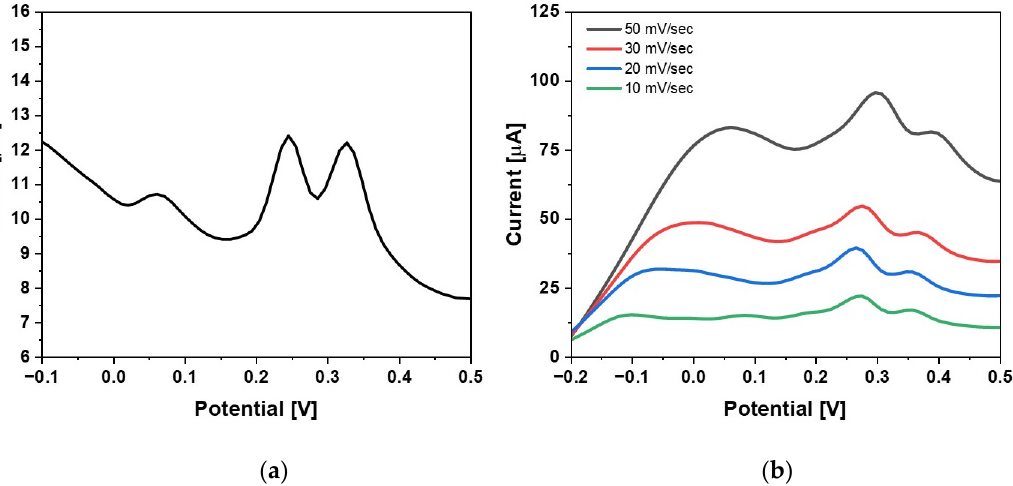
Figure 3. Oxidation peak determination. ( a ) Oxidation peaks of AA, DA and UA in whole blood using LSV; and ( b ) effect of scan rate. A scan rate of 10 mV/s was found to be